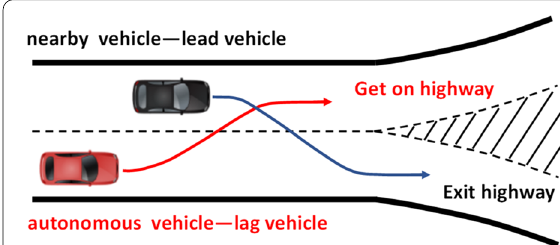
Figure 1 Lane-exchanging scenario